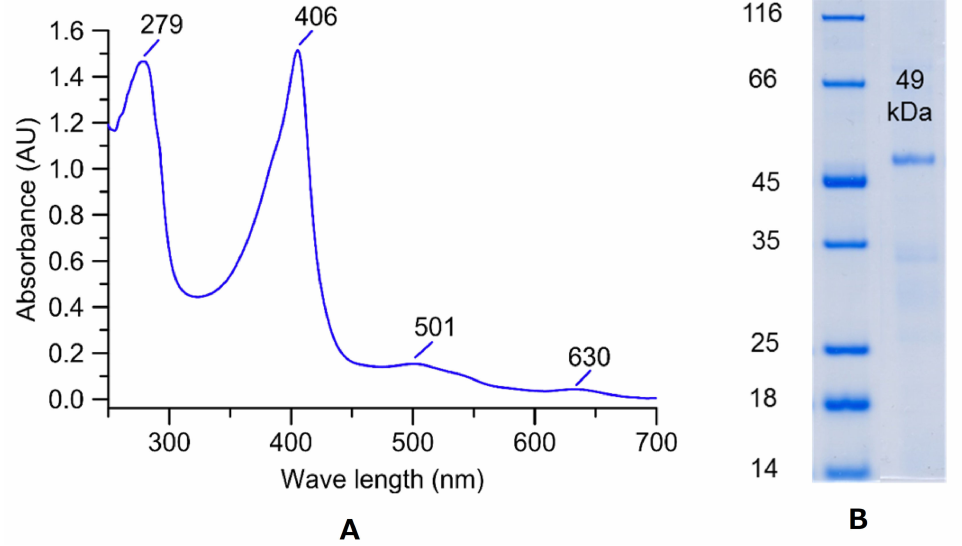
Figure 3. ( A ) UV–Vis absorption spectrum of purified Xgr DyP in its resting state with the Soret band at 406 nm and additional bands at 279, 501, and 630 nm representing the δ -, β -, and α -bands, respectively. ( B ) SDS-PAGE of the purified X. grammica DyP ( Xgr DyP; right), left: protein